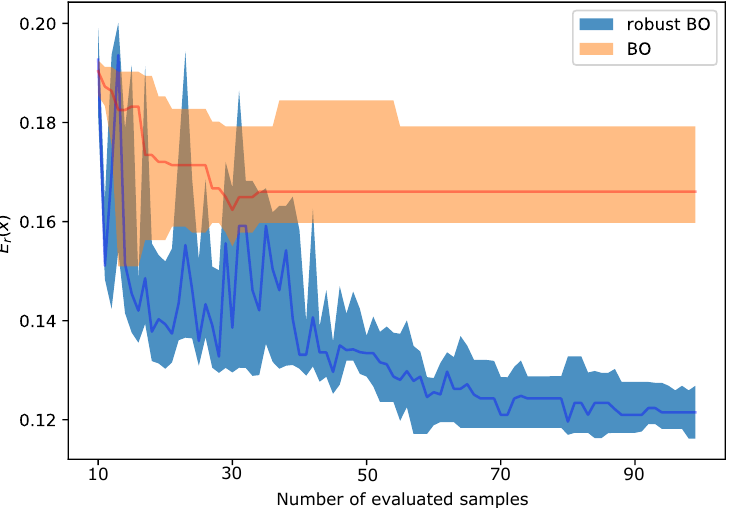
Figure 6. The expectation measure E r as a function of samples. We show the median (lines) and the 25/75th percentiles (shaded area) of the E r measure calculated for 12 different sets of initial